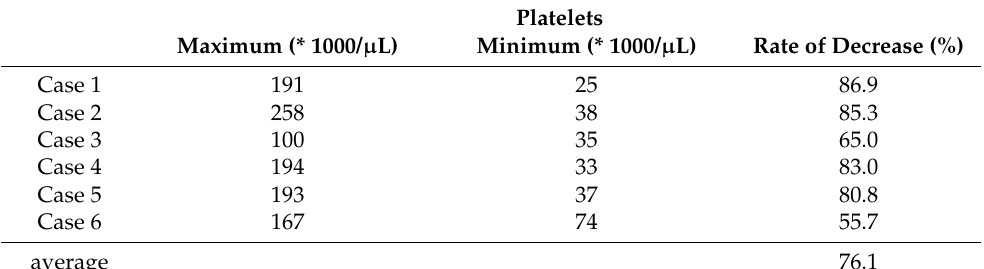
Table 2. Platelet counts decrease due to HIT.